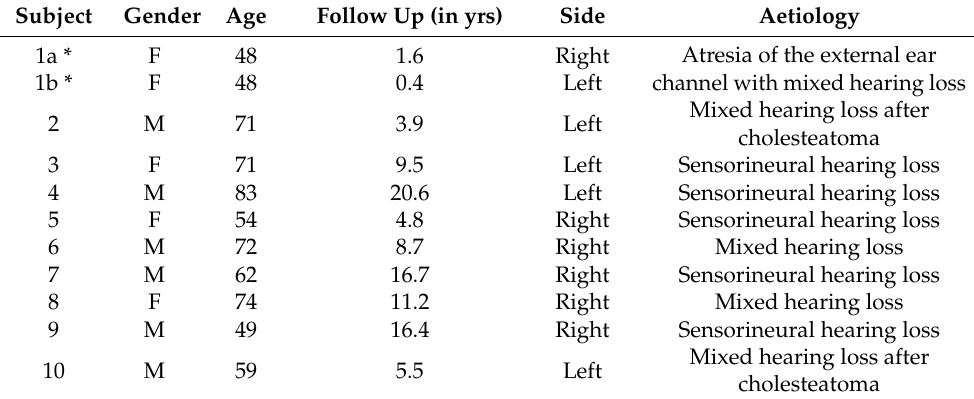
Table 1. Patients demographics and